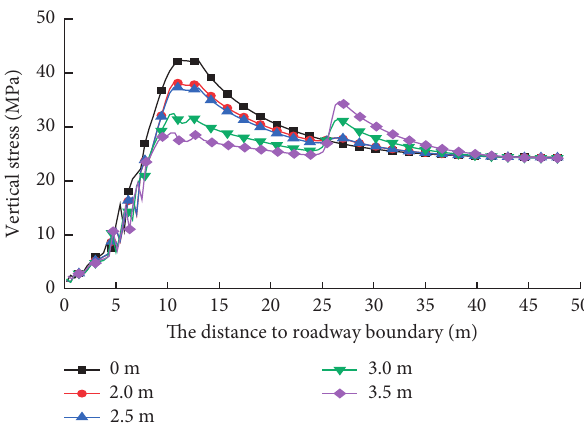
Figure 13: Vertical stress redistribution after hydraulic fracturing with different water injection fracturing radius.